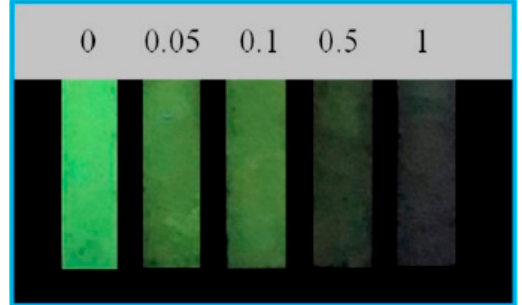
Figure 15. Colors of the dried test papers under the irradiation of UV light (254 nm) with different amounts of quercetin (mg mL − 1 ). Reprinted with permission from ref. [132], copyright 2019, American Chemical Society.